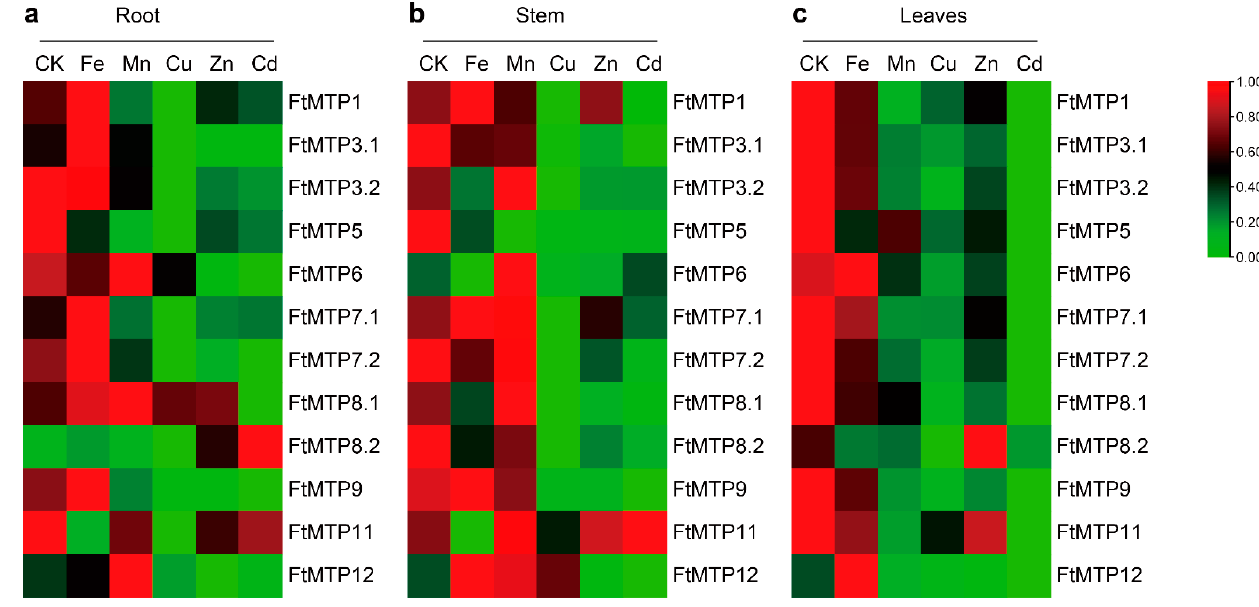
Figure 6. Heatmap expressions of the abundance of FtMTPs in different Tartary buckwheat tissues under multiple metal stress. ( a ) heatmap analysis of the abundance of FtMTPs in Tartary buckwheat root, gene expression was normalized using zero to one method; ( b ) heatmap analysis of the abundance of FtMTPs in Tartary buckwheat stem, gene expression was normalized using zero to one method; ( c ) heatmap analysis of the abundance of FtMTPs in Tartary buckwheat leaves. Gene expression was normalized and visualized by the TBtools software. CK, Fe, Mn, Cu, and Zn, appearing in Figure 6a–c, represent the root, stem, and leaves of Tartary buckwheat under normal conditions, Fe 3+ , Mn 2+ , Cu 2+ , and Zn 2+ treatments, respectively.